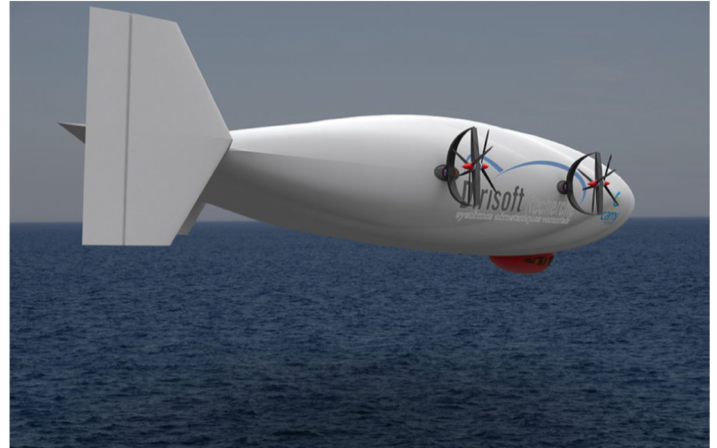
Figure 1. The flying wing airship MC